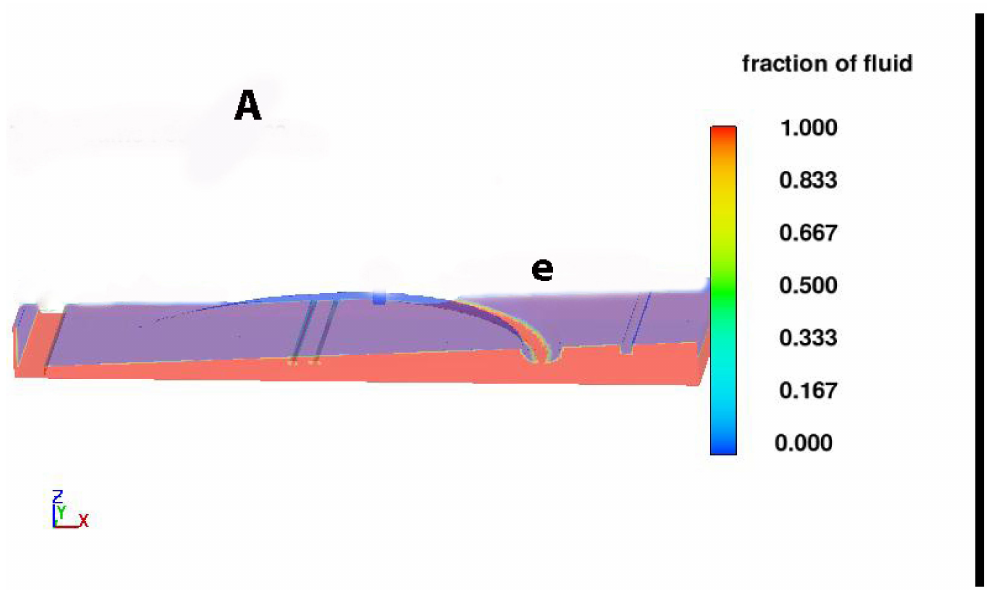
Figure 13. Constant y transect through the D drainage channel (Figure 1a) of groundwater profile for rainy season ground saturation conditions. The ff = 1 fluid fraction condition indicates layer aquifer saturation and bottom saturation of the perimeter drainage channel bed proceeding from design depth of the perimeter drainage